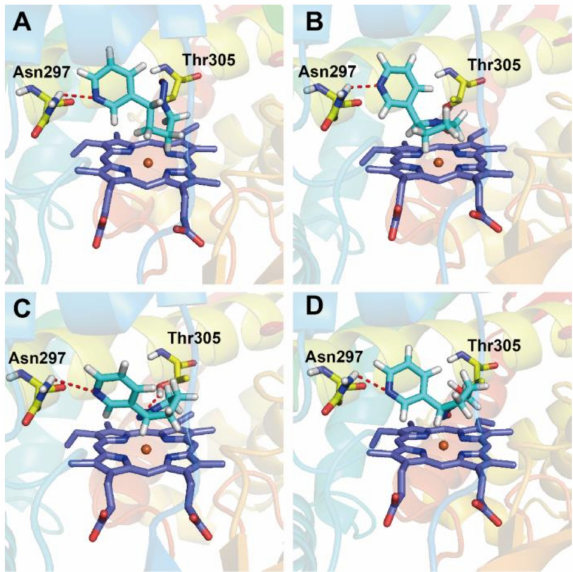
Figure 7. Optimal docking results of ( R )- or ( S )-NNN with different CYP450 enzymes. Docking conformations of ( R )-NNN ( A ) and ( S )-NNN ( B ) with rat CYP450 2A3 enzyme, and docking conformations of ( S )-NNN with human CYP450 2A6 enzyme ( C ) and human CYP450 2A13 enzyme ( D